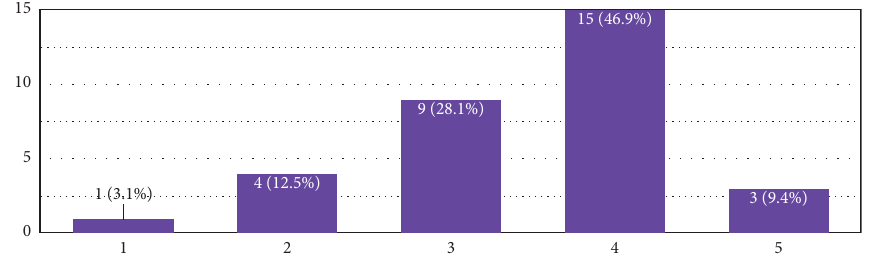
Figure 5: In the X -axis, “1” represents the polarised value “challenging,” “5” represents the polarised value “easy,” and the remaining are the extrapolations in the middle as per the Likert scale. Te Y -axis represents the number of responses.